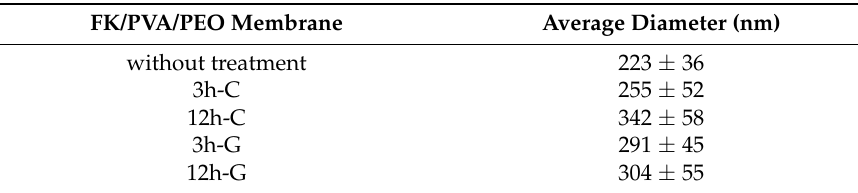
Table 1. The average diameter of the FK/PVA/PEO nanofiber membranes with different vapor-assisted crosslinking modifications.